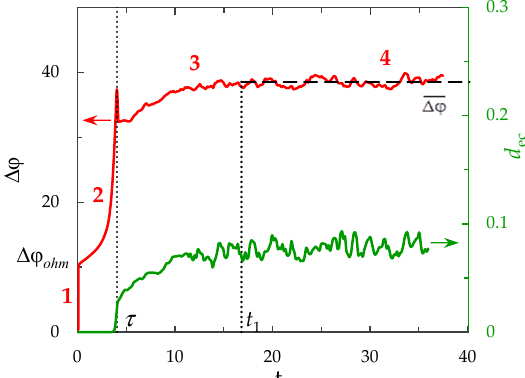
Figure 1. ChP (red line) calculated for the electrolyte solution layer near the surface of the ion exchange membrane, taking into account the development of electroconvection at the overlimiting current density. The dotted lines show the transition time, τ , and the approximate time to establish a quasi-stationary state, t 1 . The green line represents the dynamics of the averaged over the channel length thickness of the electroconvective mixing layer, d ec . All quantities are given in dimensionless form (dimensionless voltage unit corresponds to approximately 0.026 V, time unit is 0.066 s, unit of electroconvective mixing layer thickness, d ec , is 0.25 mm). Adapted from [20].